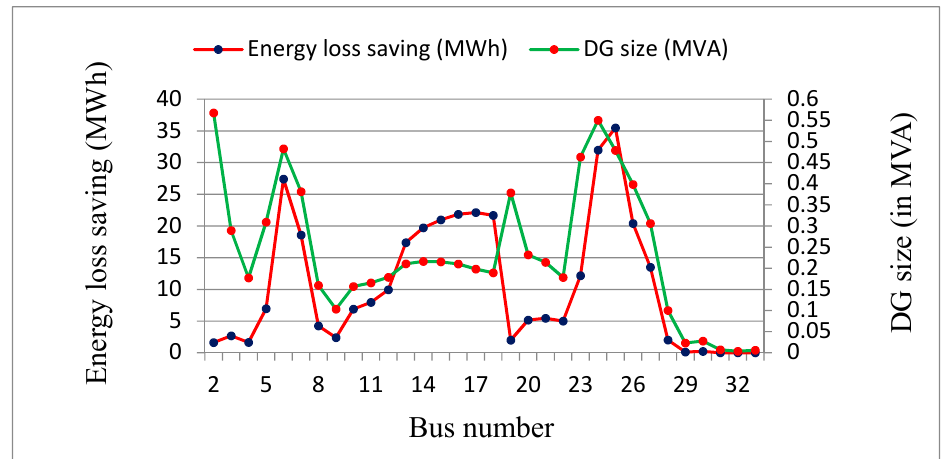
Figure 15. Optimal DG size (in MVA) and corresponding energy loss saving (in MWh) with DG at node 6 for various nodes for the IEEE 33-bus system.